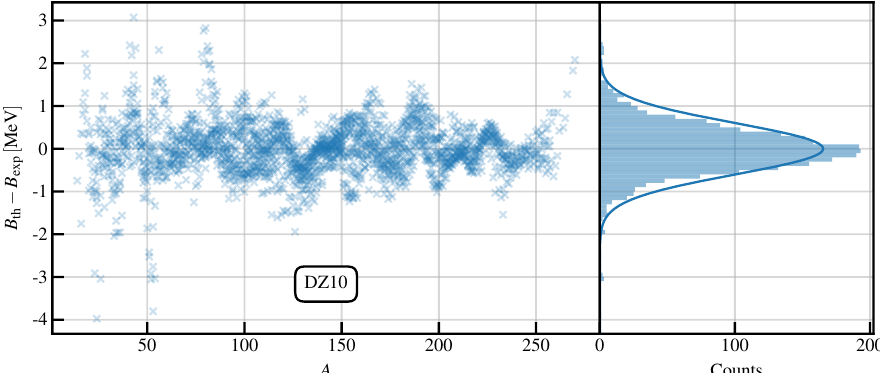
Figure 3. Left panel: residuals as a function of nucleon number A for the DZ10 model, for measured masses. In the right panel are the same residuals shown as a histogram, with a Gaussian fit overlaid (for which the mean is fixed to 0, and the standard deviation to that of the residuals). See text for